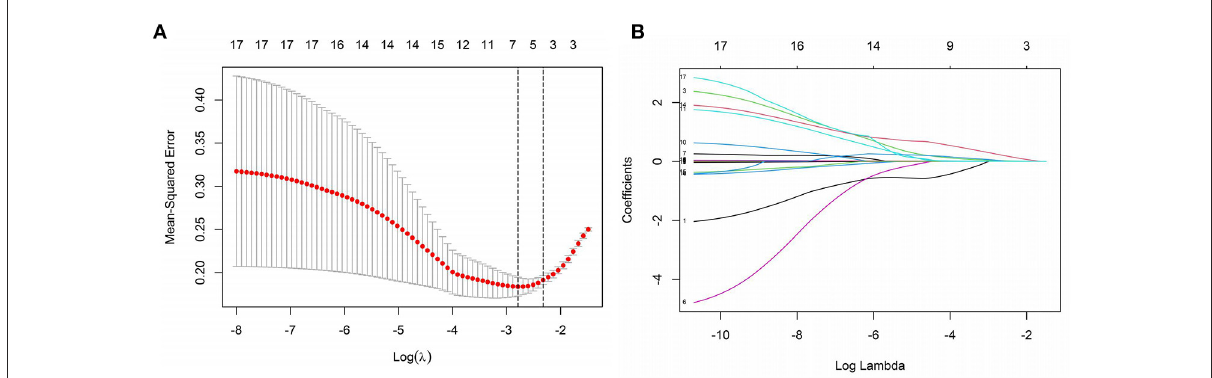
FIGURE1 Screening of independent variables based on LASSO regression. (A) The optimal value of parameter λ is screened in the LASSO model using the minimum criterion for 10-fold cross-validation [the two dashed lines in the figure indicate the λ and 1-se values of the minimized mean square error (MSE)]. (B) LASSO regression screening variables profile (Lambda optimal take when screening retention variables).